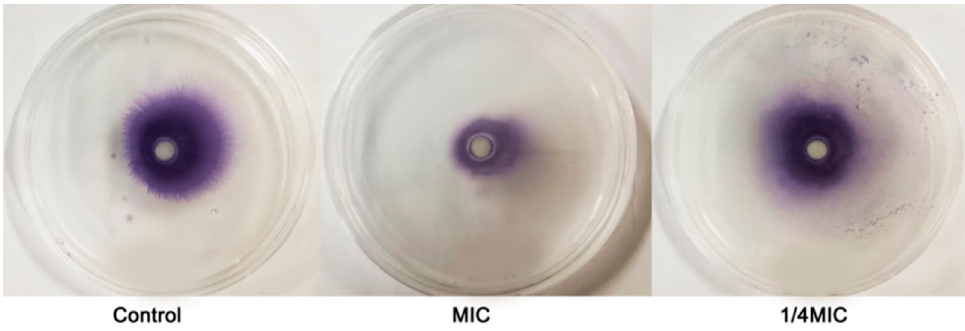
Figure 6. Inhibition of C. camphora EO on C. violaceum .